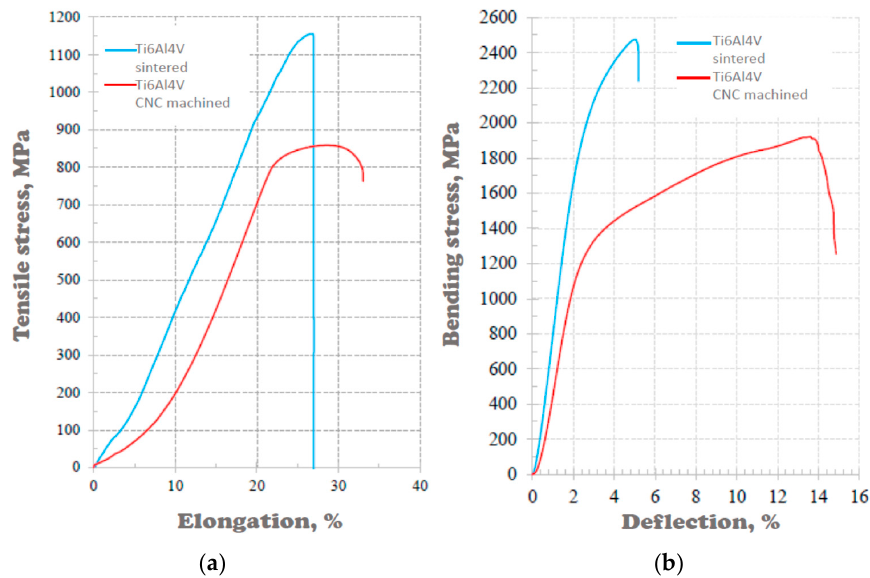
Figure 11. Comparison of tensile stress ( a ) and bending stress ( b ) for micro specimens of the Ti6Al4V alloy manufactured by SLS and the Ti6Al4V casting alloy produced by milling in a computer numerically controlled (CNC) centre.